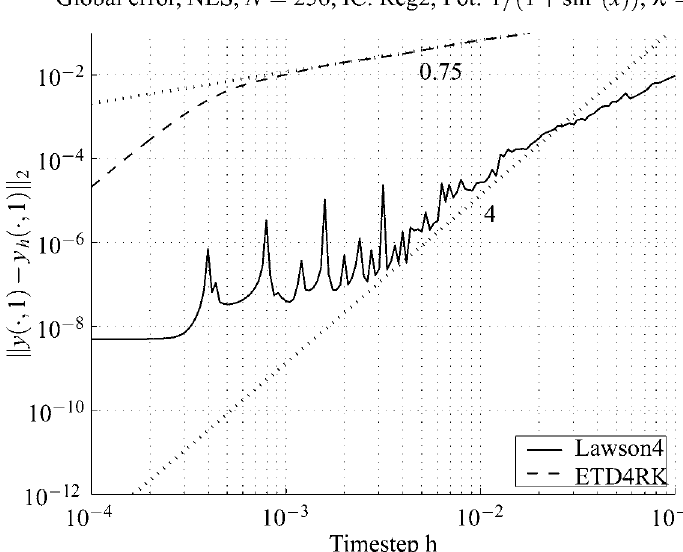
Figure 7. Lawson4 is close to order 4 but oscillating in the linear case, (cid:2) (cid:1) 0, while ETD 4 RK suffers from the low regularity (2) of the initial function. The potential is smooth, 1/(1 (cid:4) sin 2 ( x )). In the corresponding local error plot, ETD 4 RK exhibits order 1.75 and Lawson order 5 with no